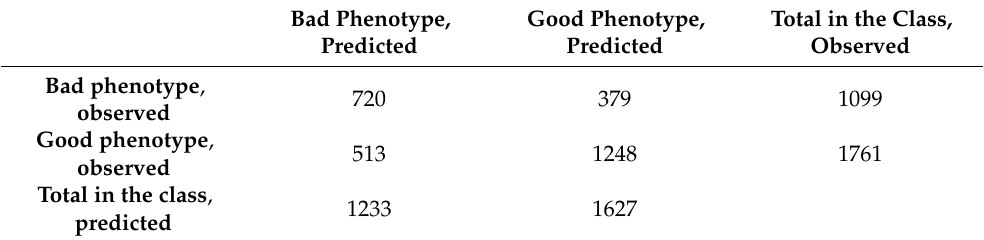
Table 3. Confusion matrix for the minimal classification model based on cellular parameters, showing the numbers of correctly and incorrectly classified cells in the groups of the good and bad phenotypes of their colonies. The numbers have the same meaning as in Table 2 but refer to cells, not colonies.